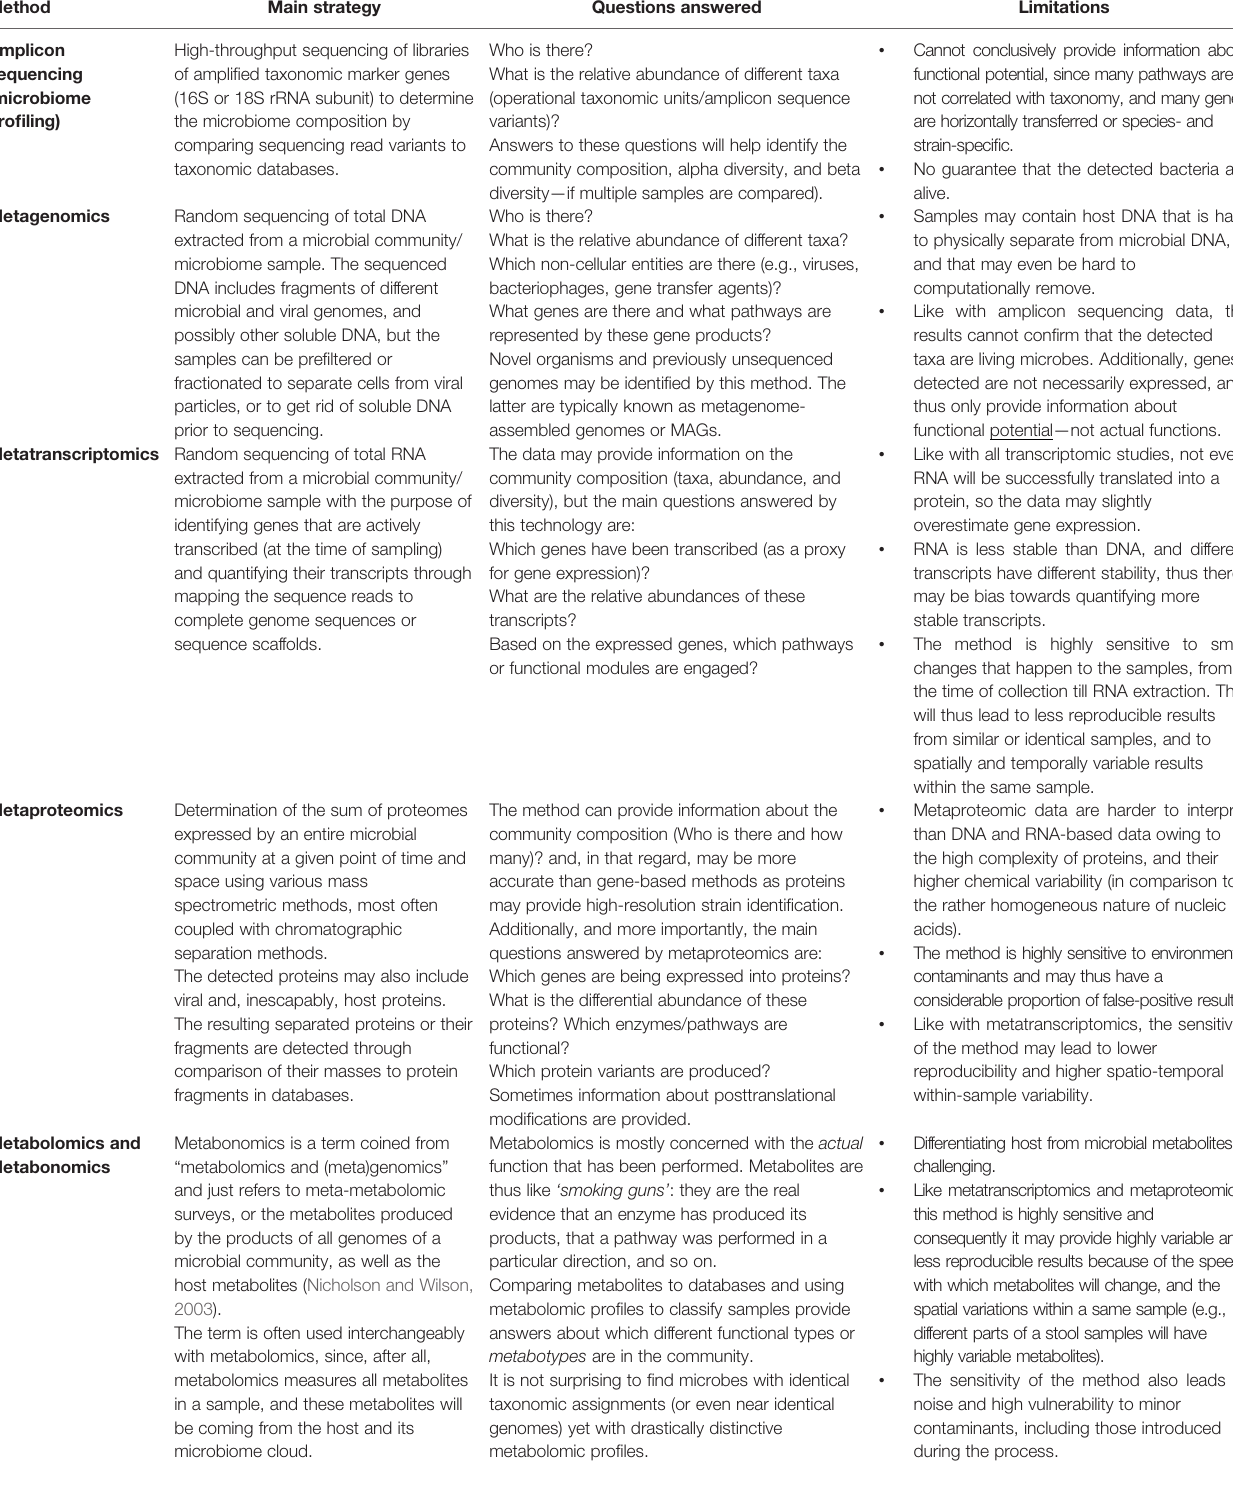
TABLE 3 | Omics tools and technologies used in toxicomicrobiomic